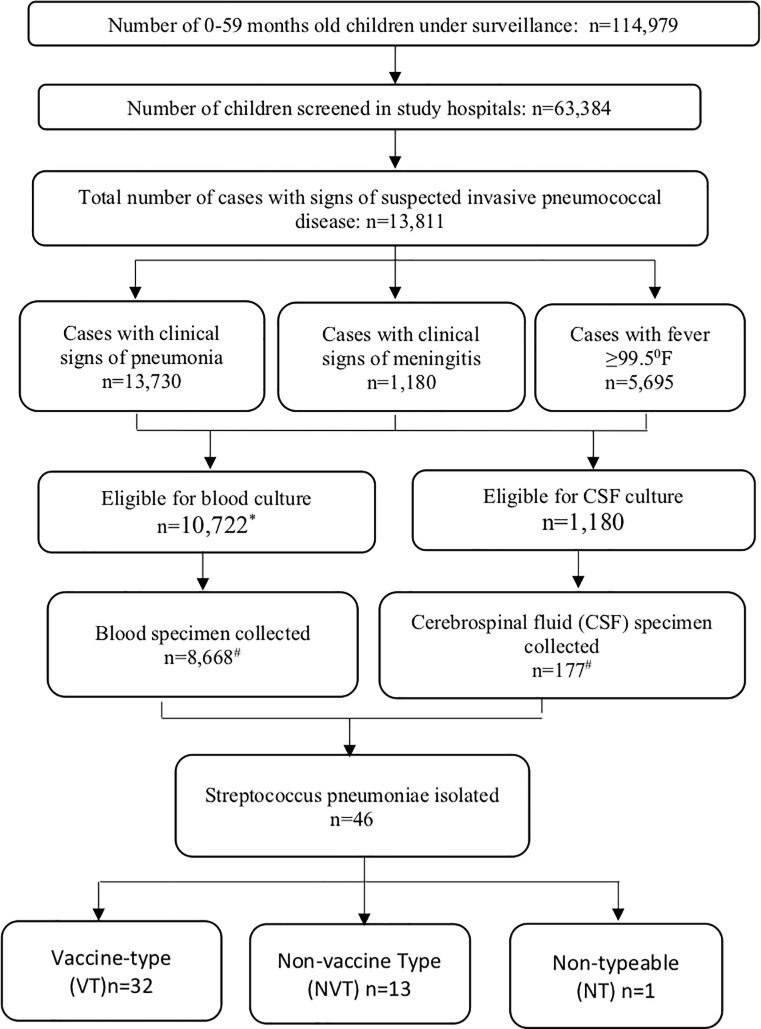
Study flow chart, January 2014—June 2015.